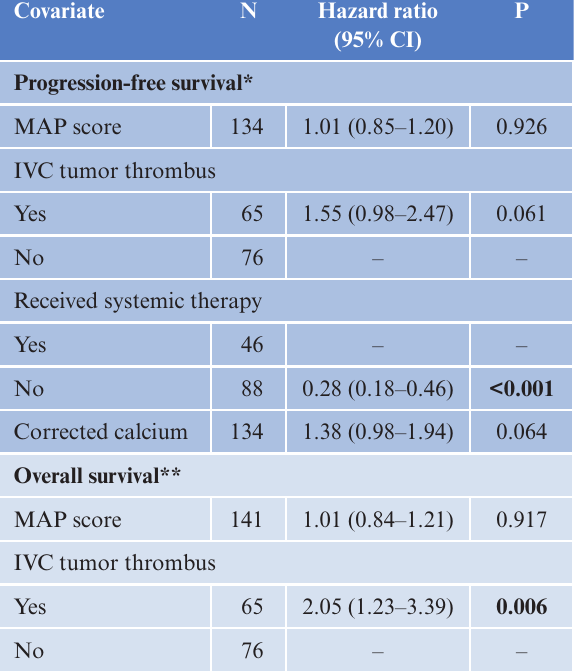
Table 2: Multivariable cox proportional hazard model for progression-free survival and overall survival.